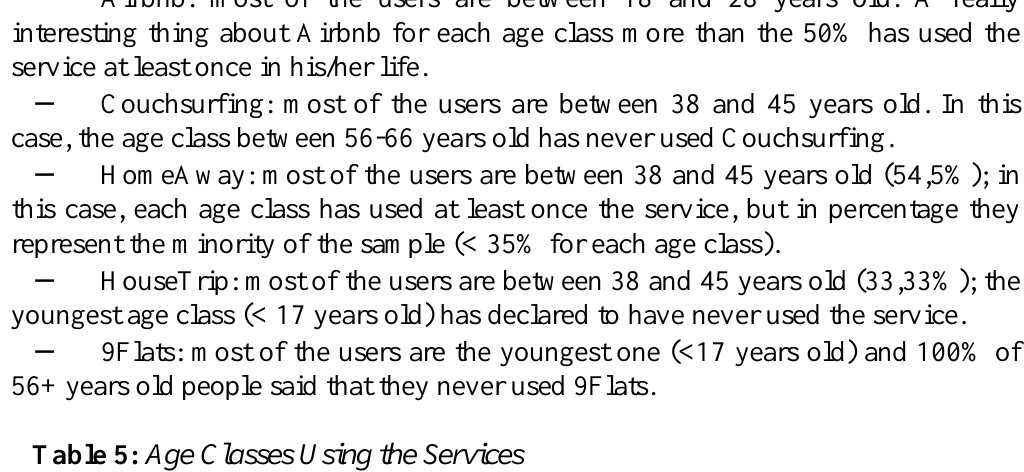
Table 5: Age Classes Using the